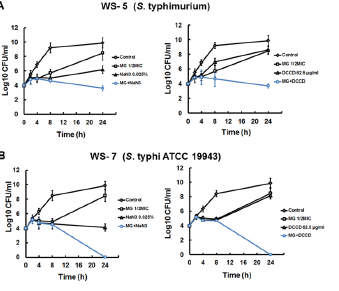
Figure 2. Time-kill curves for (A) S . Typhimurium (WS-5) and (B) S . Typhi ATCC 19943 (WS-7) with MG and ATPase inhibitors (DCCD and NaN3). These results were confirmed in three indepen- dent experiments. PLOS ONE |